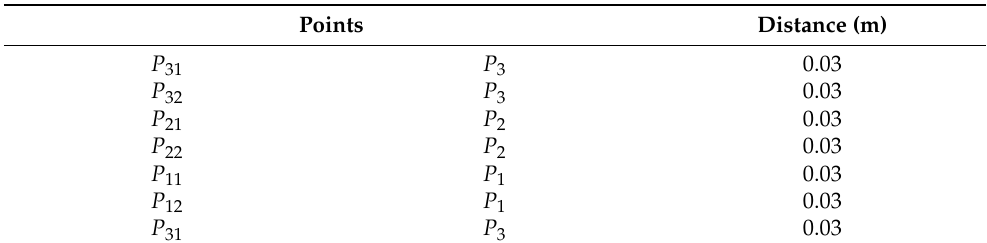
Table 3. The distance between points.